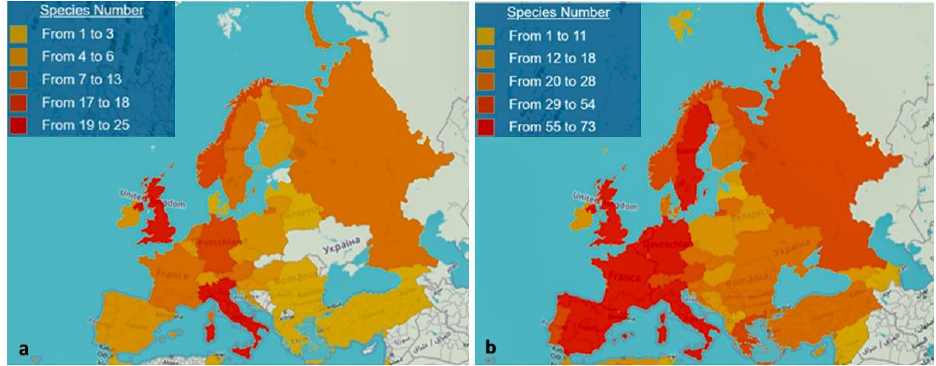
Figure 2. EU geographical distribution of invasive alien species of fungi ( a ) and insects ( b ) intro- duced into terrestrial and fresh-water environments from 1999 to 2021 (source: EASIN — European Alien Species Information Network). Fresh-water environments were also surveyed to include wa- ter moulds (Oomycetes).